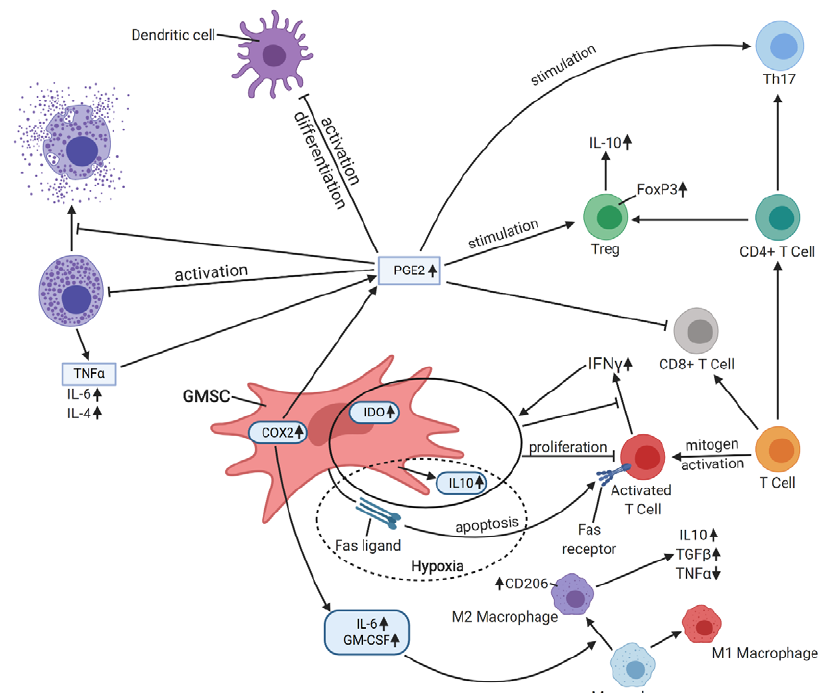
Figure 2. A schematic immunomodulatory activity of GMSCs. GMSCs exert apoptotic effects on